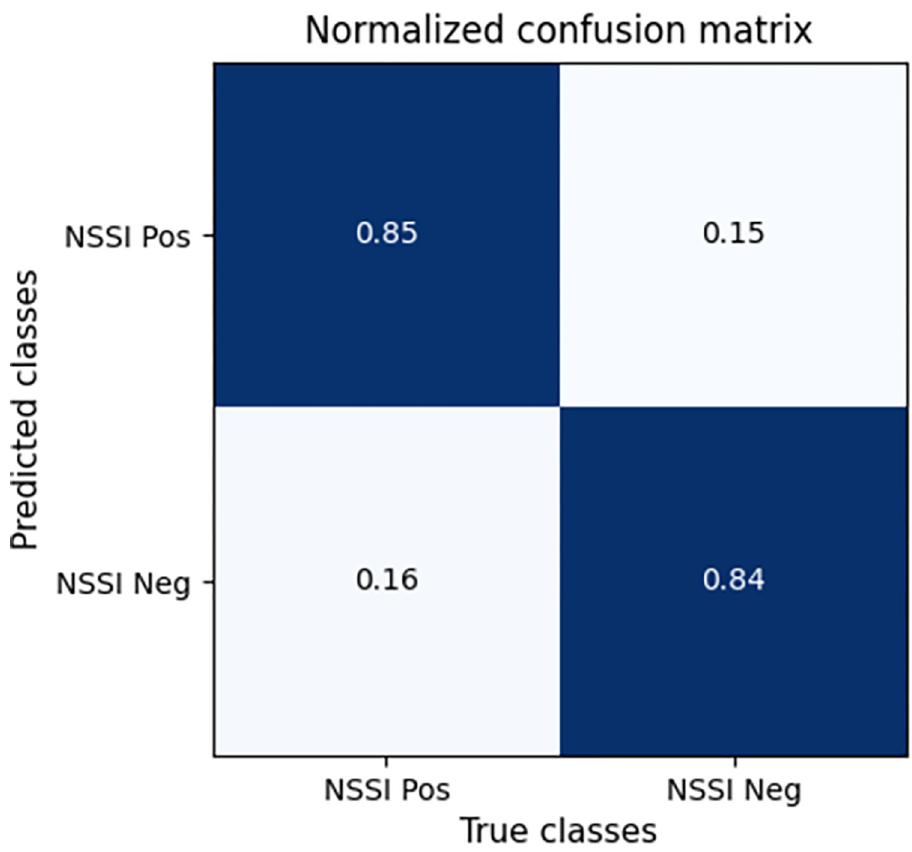
Fig 2. Normalized confusion matrix of the MLP